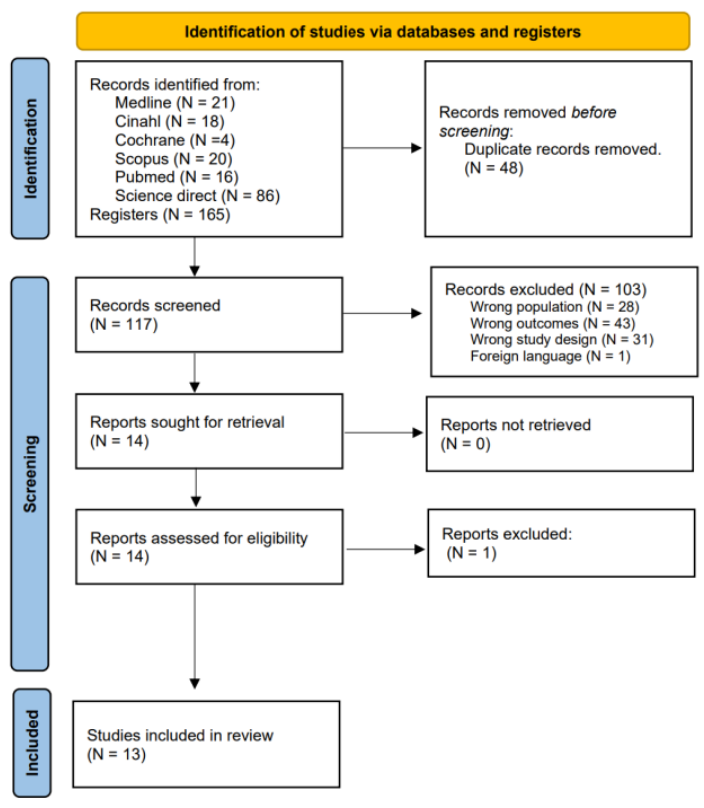
Figure 1. PRISMA Flow diagram.